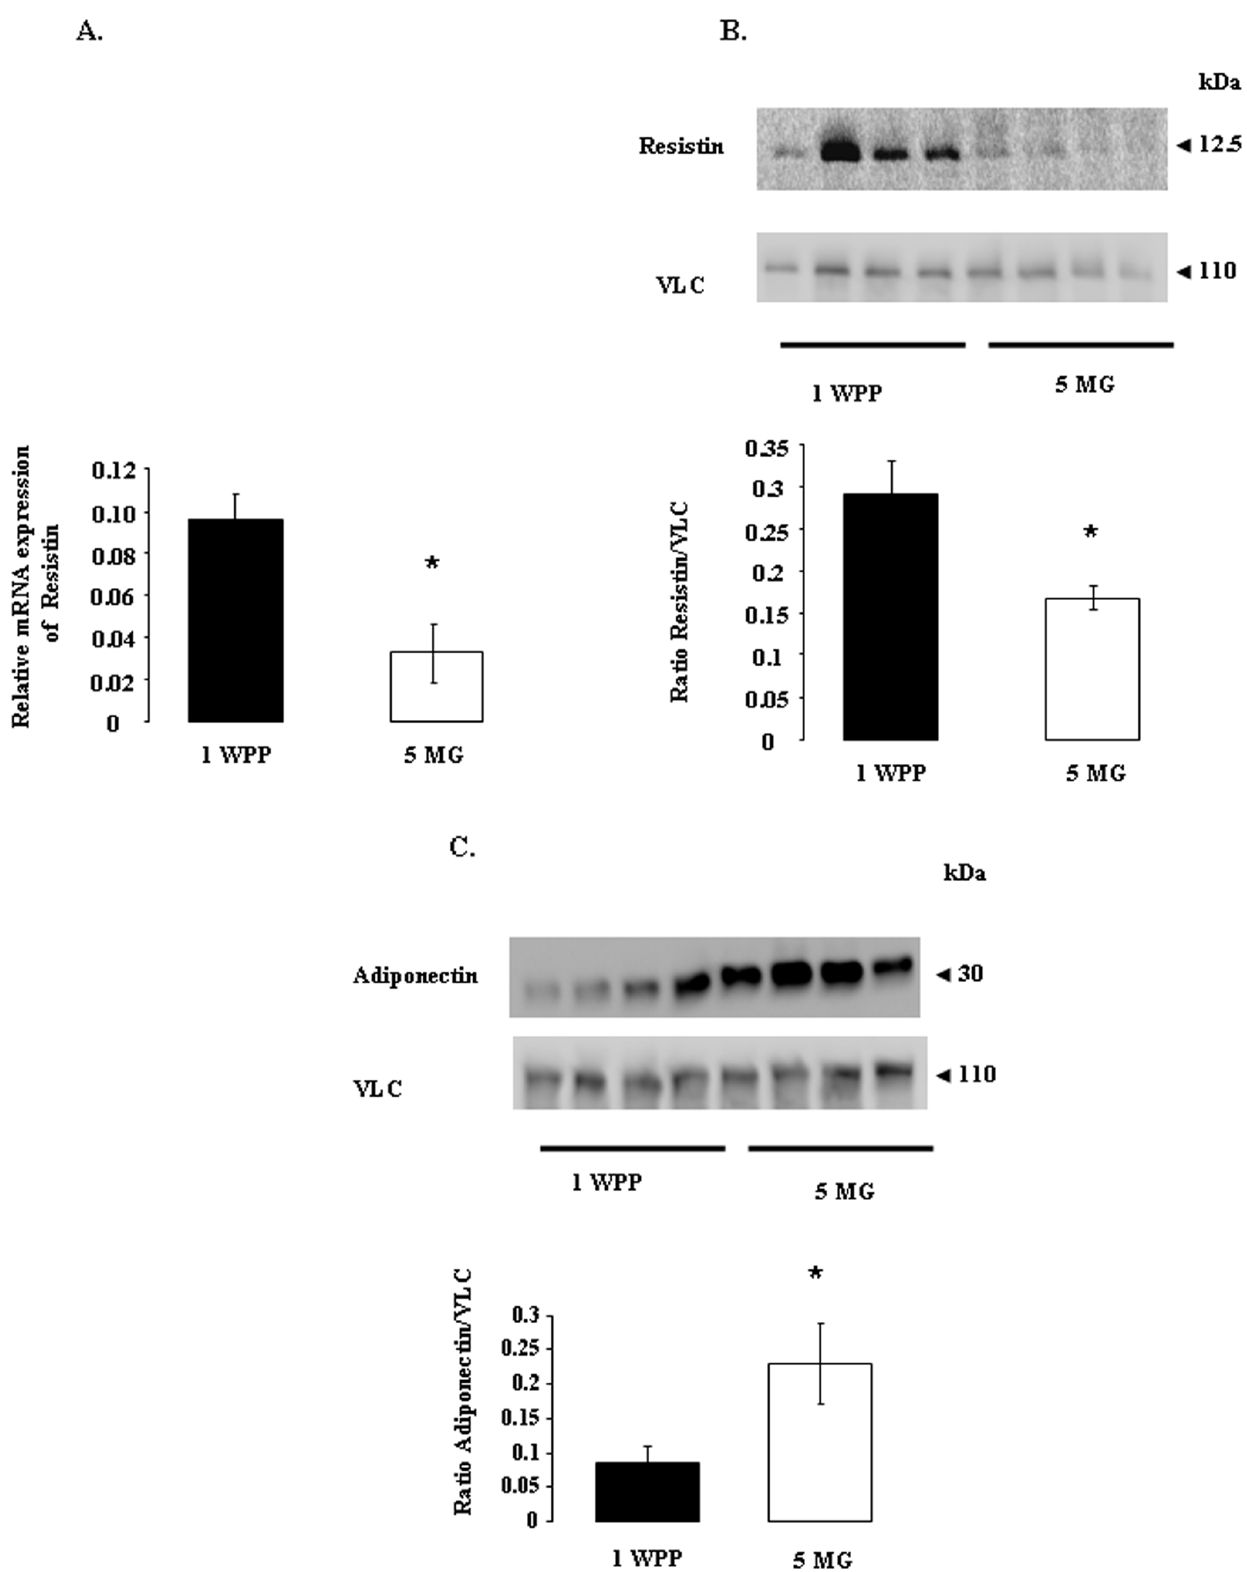
Figure 3. Resistin mRNA and protein levels and adiponectin protein levels in bovine adipose tissue at one week post partum (WPP 1) and 5 months of gestation (5 MG). A. Resistin gene expression was assessed by quantitative reverse transcription-polymerase chain reaction on bovine adipose tissue at one week post partum (WPP 1, n =8 animals) and 5 months of gestation (5 MG, n =8 animals), as described in the materials and methods. Relative expression was measured relatively to the geometric mean of 4 reference gene expression [cyclophilin A (PPIA),